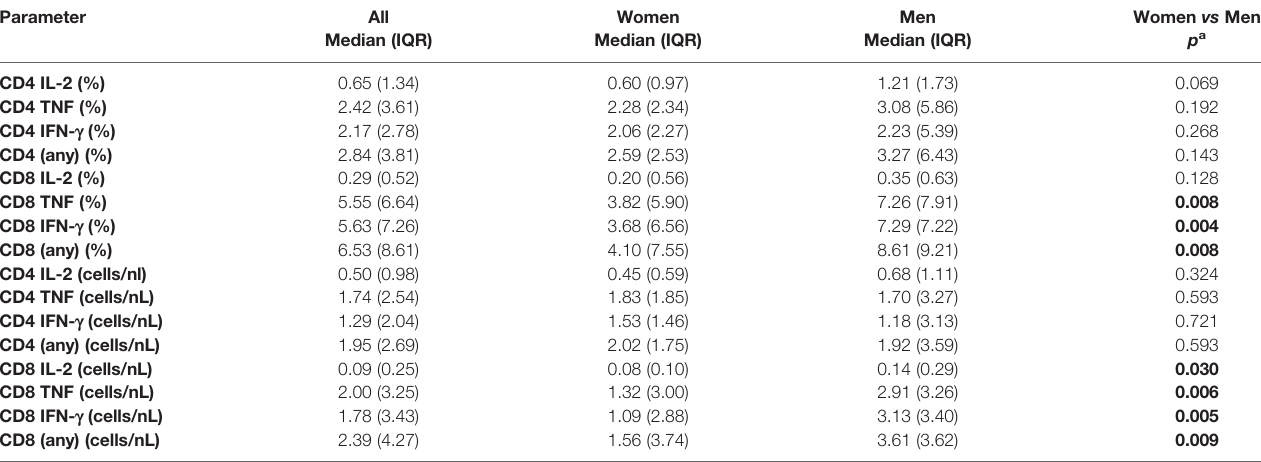
TABLE 2 | Overall CMV-speci fi c response size in men and women. Parameter